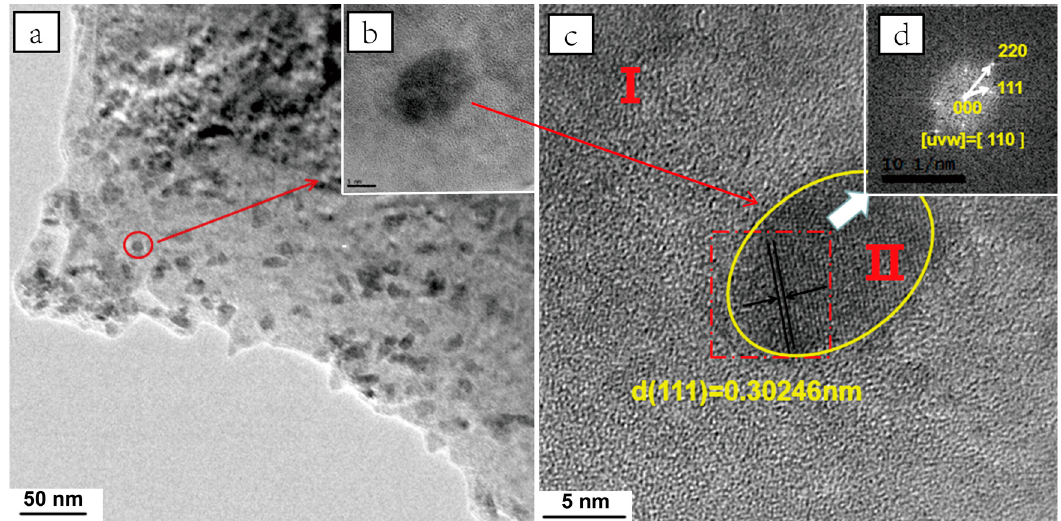
Figure 7. The transmission electron microscope (TEM) images and Fast Fourier transform (FFT) analysis of TMCs refined and reinforced by in situ Ti 5 Si 3 /Ti composite ribbon inoculants: ( a ) TEM image of TMCs; ( b ) TEM image of the Ti 5 Si 3 particle in TMCs; ( c ) HRTEM image of nano-Ti 5 Si 3 particle microstructure; ( d ) FFT analysis in the selected area II in Figure 7c.